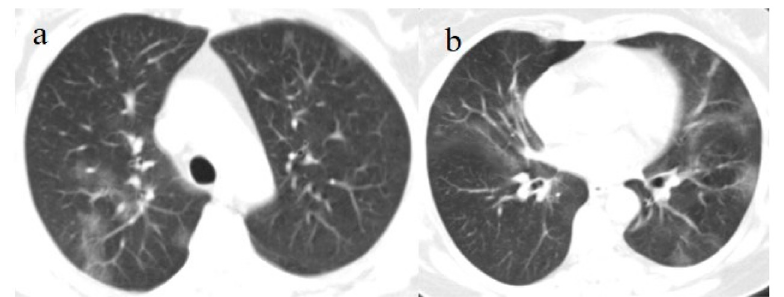
Figure 4. Chest CT performed on 3 July, showing in the image ( a ) that some GGO areas remained bilaterally present in the superior lobe and in the image ( b ) in the middle and inferior lobe with a multifocal